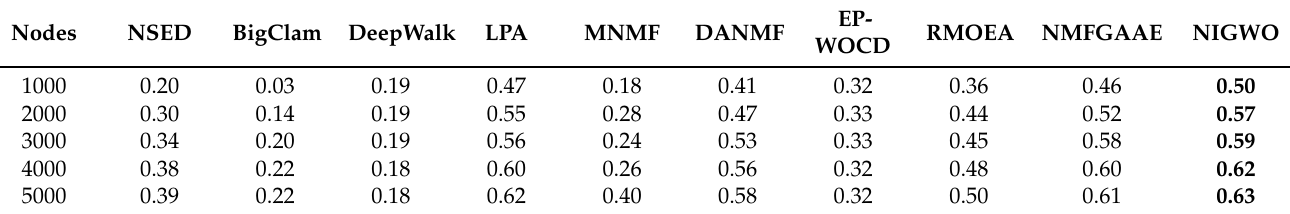
Table 6. NMI comparison for LFR with different